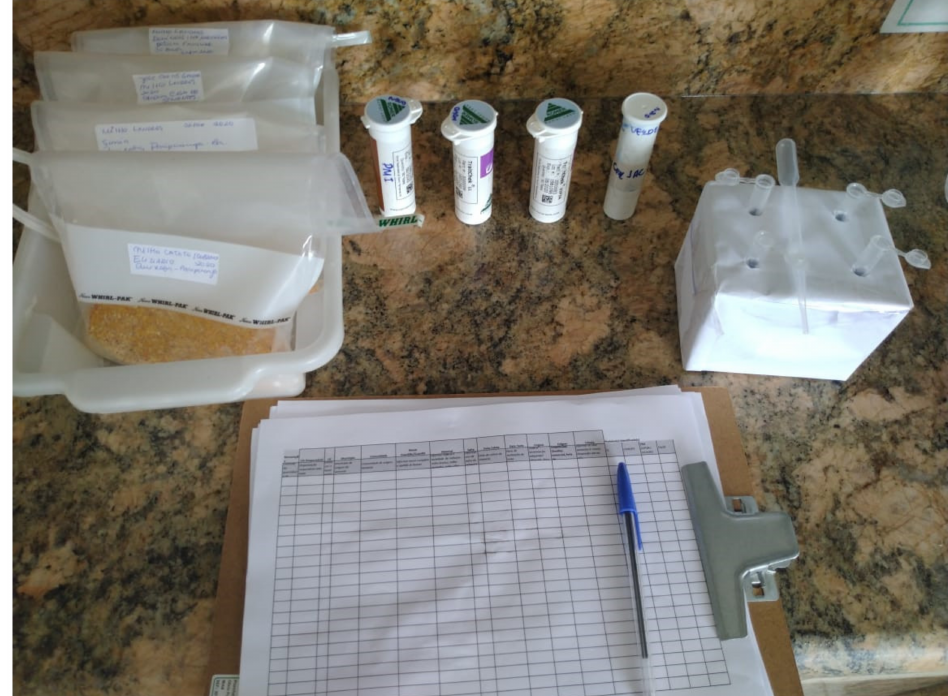
Figure 10. Identified samples of maize landraces seeds submitted to the strip test. Photo credit: Semi-arid Agrobiodiversity Management Program and Agrobiodiversity of the Semi-arid Project image bank. C í cero Dantas, Bahia, Brazil, February